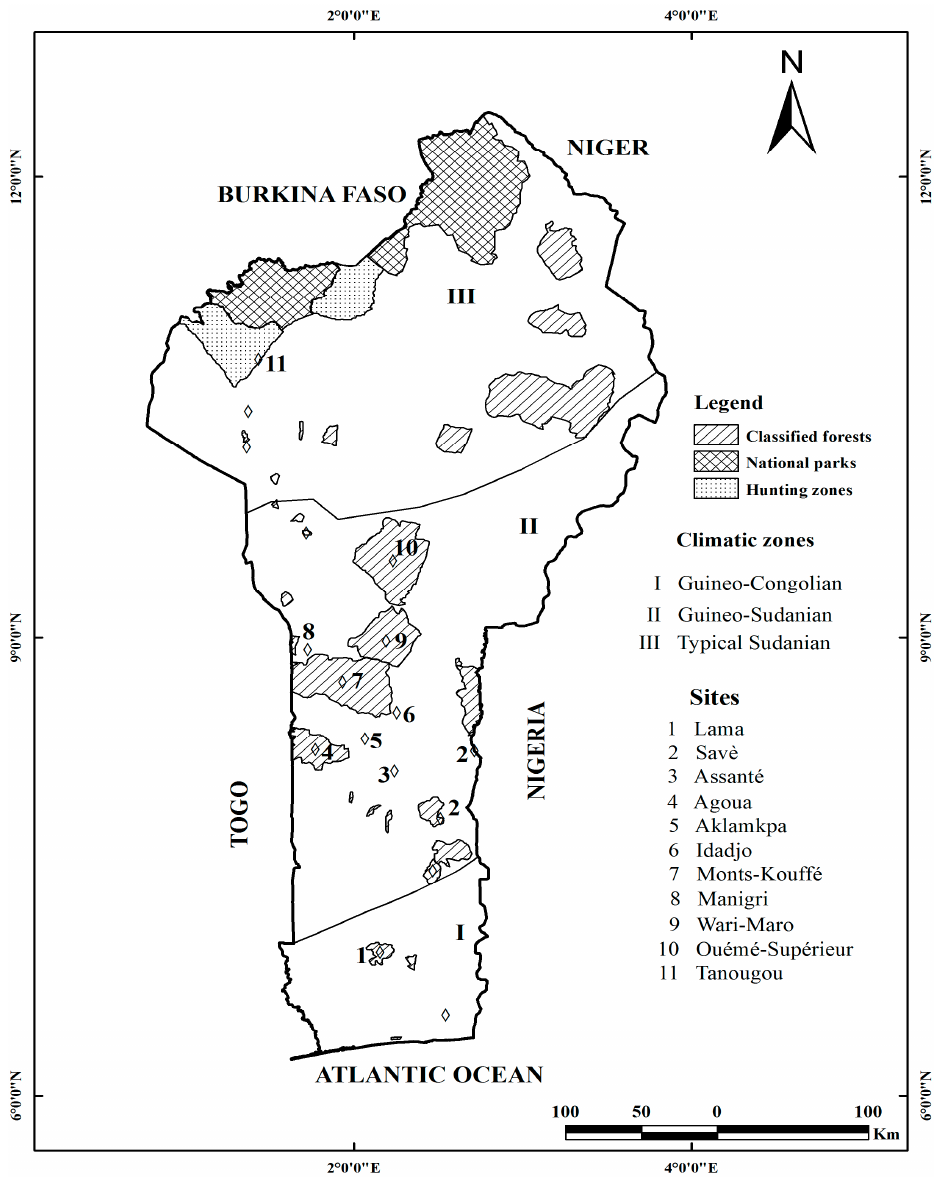
Figure 1. Climatic zones and study site locations and attributes in Benin, W. Africa.